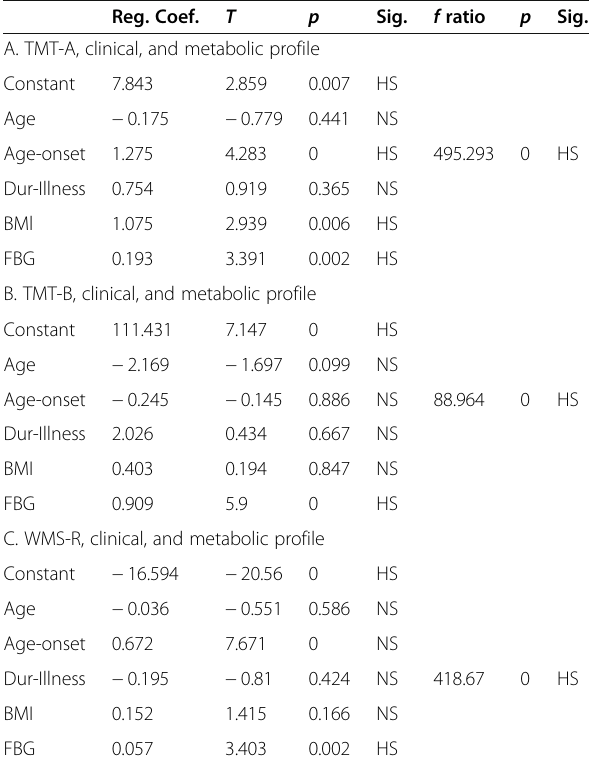
Table 4 Multiple regression analysis data of patients ’ cognitive, clinical, and metabolic profiles Reg.